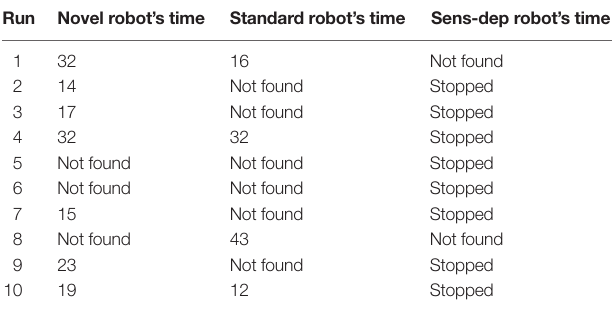
TaBle 3 | results of the hidden-toy